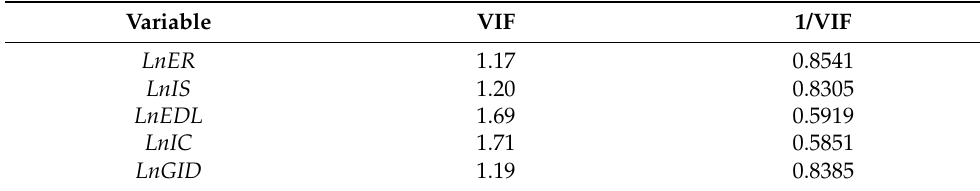
Table 2. The collinearity diagnosis